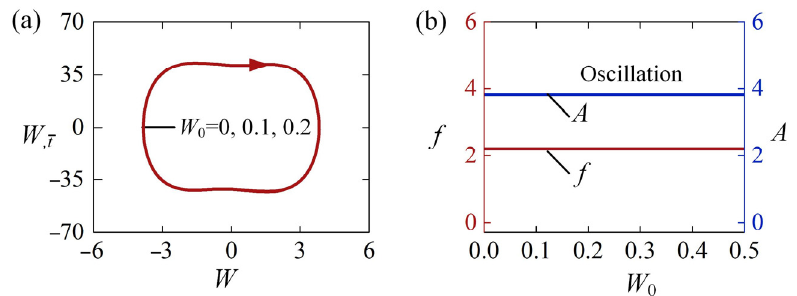
Figure 8. The effect of initial condition W 0 on the self-sustained Euler buckling of the LCE rod, for ε 0 = 20, β = 0.8, T 0 = 0.5, and W t 0 = 0. ( a ) Limit cycles. ( b ) Frequency and amplitude. The initial condition has no effect on the self-sustained Euler buckling of the LCE rod.